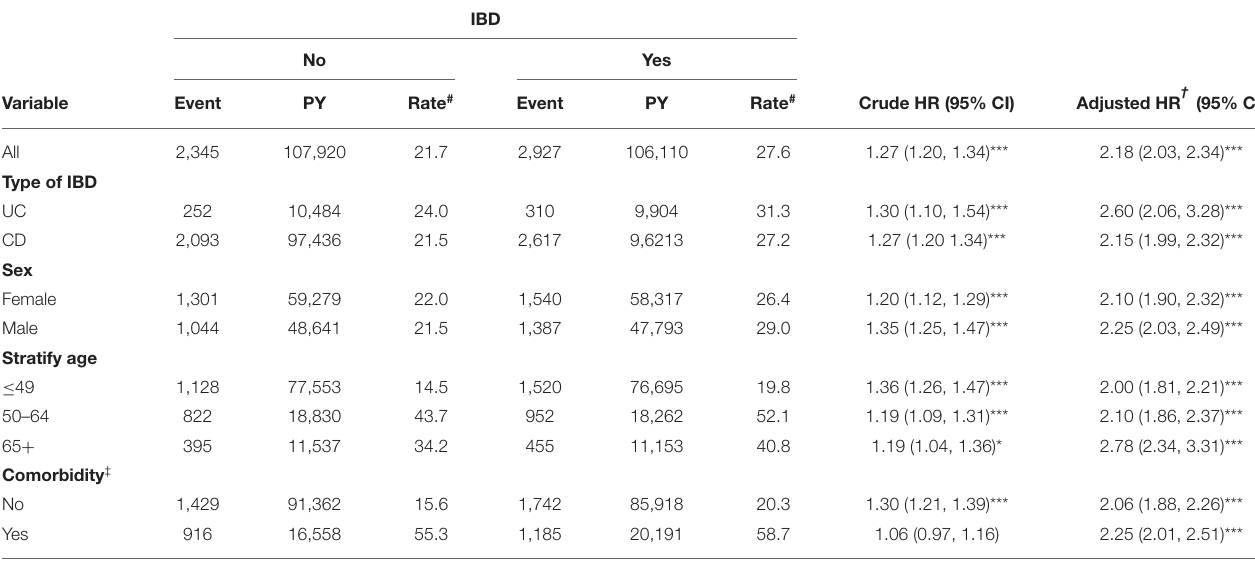
TABLE 3 | Comparison of incidence (CI) and hazard ratio (HR) of hyperlipidemia stratified by sex, age, and comorbidities between with and without inflammatory bowel disease (IBD). IBD No Yes Variable